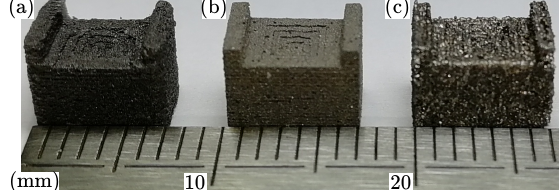
Figure 6. Picture of the back-bias magnets printed by: ( a ) FFF, ( b ) SLA, ( c )